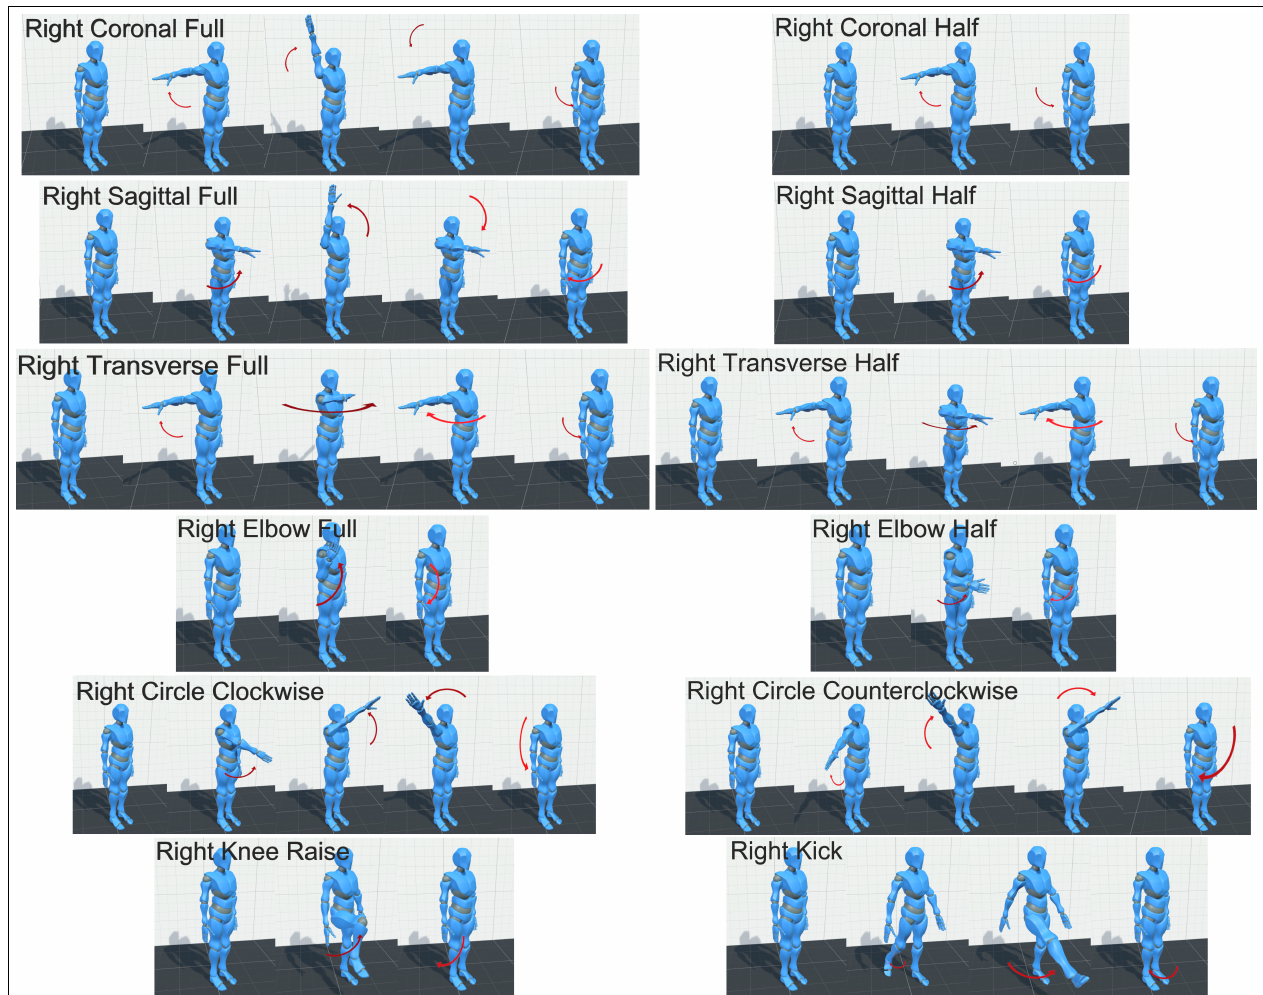
Figure 3. Sequence of 12 movements related of right side of the body (both sides have 24 movements in total).